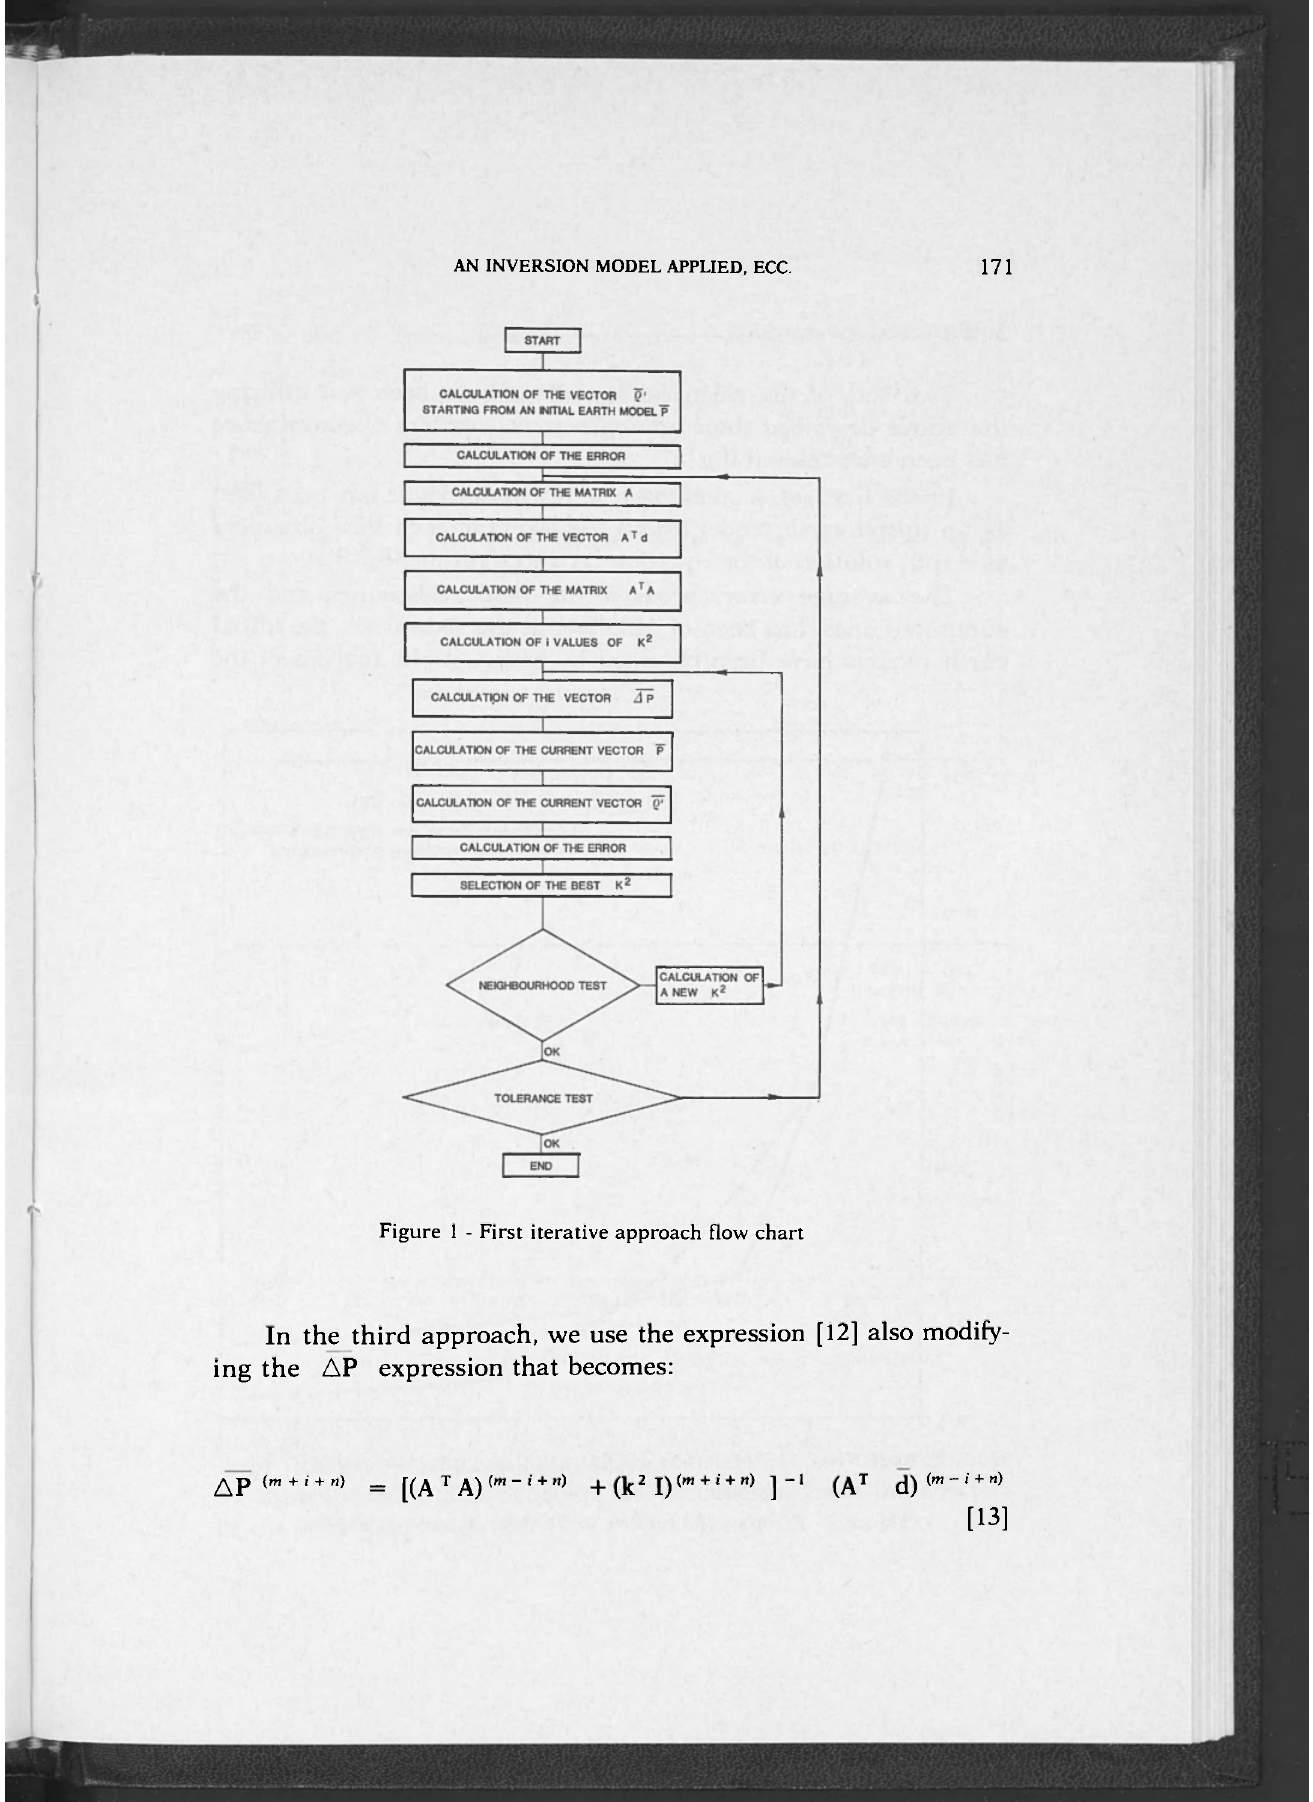
Figure 1 - First iterative approach flow